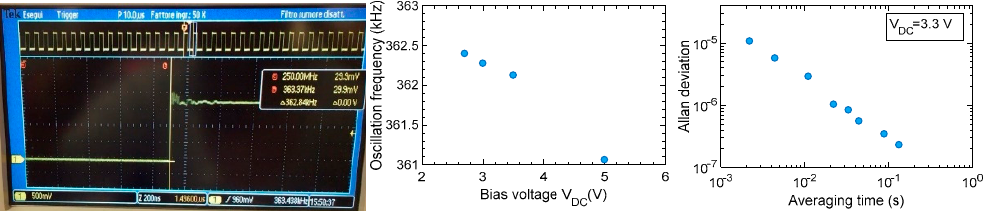
Figure 4. ( a ) Output square wave whose frequency matches the resonance frequency of the DETF, in this case the natural resonance frequency is approximately 362 kHz. ( b ) Variation of the oscillation frequency due to changes in the applied V DC . ( c ) Estimated Allan